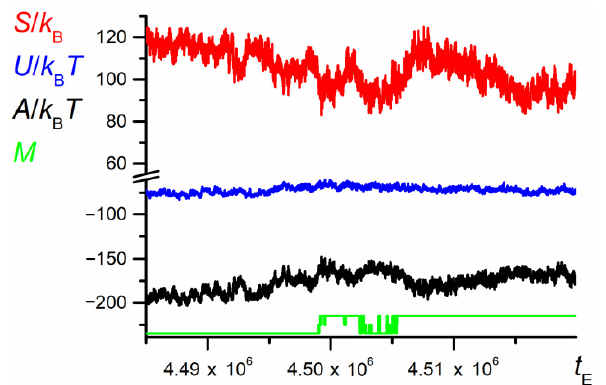
Figure 14. The dependence of entropy, internal energy, and Helmholtz energy of the chain on the number of elementary steps, t E , for the fragment of trajectory from Figure 12 ( N = 100, ε PP / k B T = − 1 and 0 for P1 and P2, respectively, D = 3 b ). The chart is based on the data recorded at each elementary step.